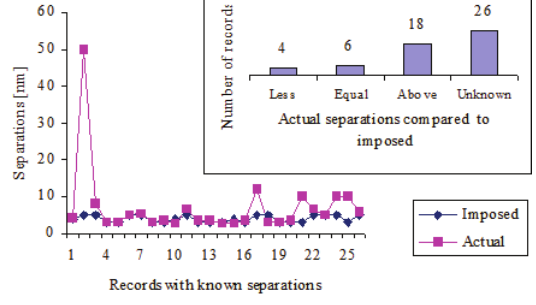
Figure 10. Reported separations compared to the UK imposed separations